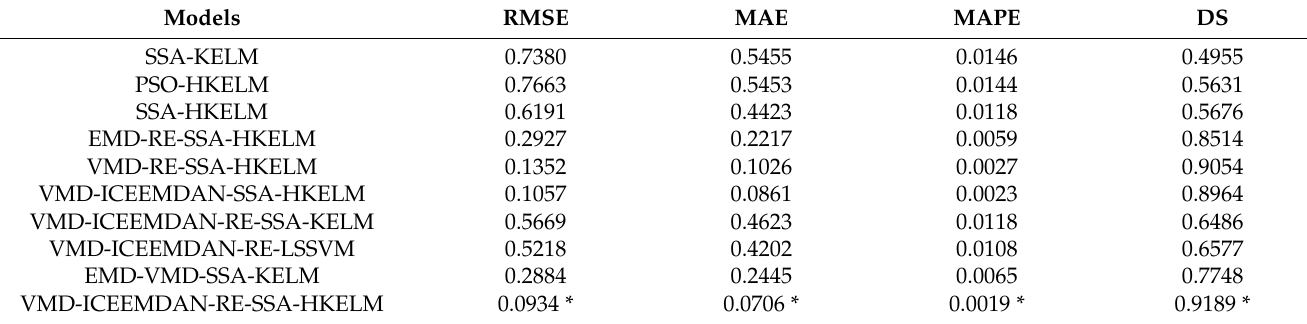
Table 7. Comparison of the methods for forecasting the price of carbon in the Guangzhou market.